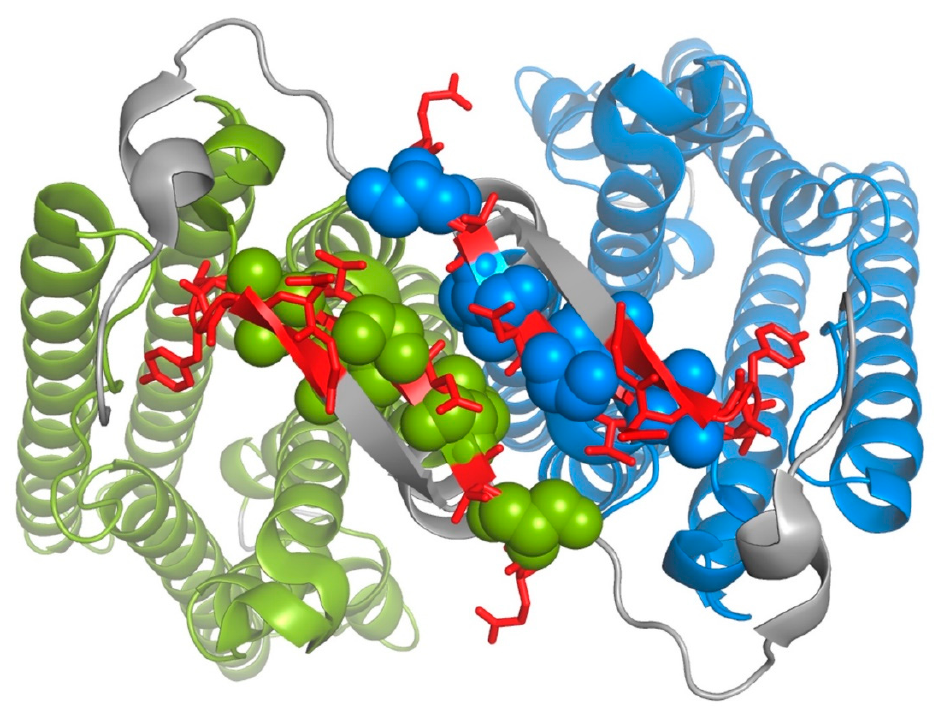
Figure 3. Accessibility of the N-terminal region of Ste2p mapped onto the structure of the ligand- free Ste2p dimer (PDB code: 7QB9) [37]. Sites in the N-terminal region where introduced cysteine substitutions could be labeled by MTSEA-biotin are shown as red sticks. Sites in the N terminus that could not be labeled by MTSEA-biotin are shown as green and blue spheres for the two different monomers. Sites in the N-terminal region that were not tested for MTSEA-biotin labeling are shown in grey. Portions of Ste2p other than the N terminus are depicted using cartoon representation, colored green and blue, respectively, for the two monomers.